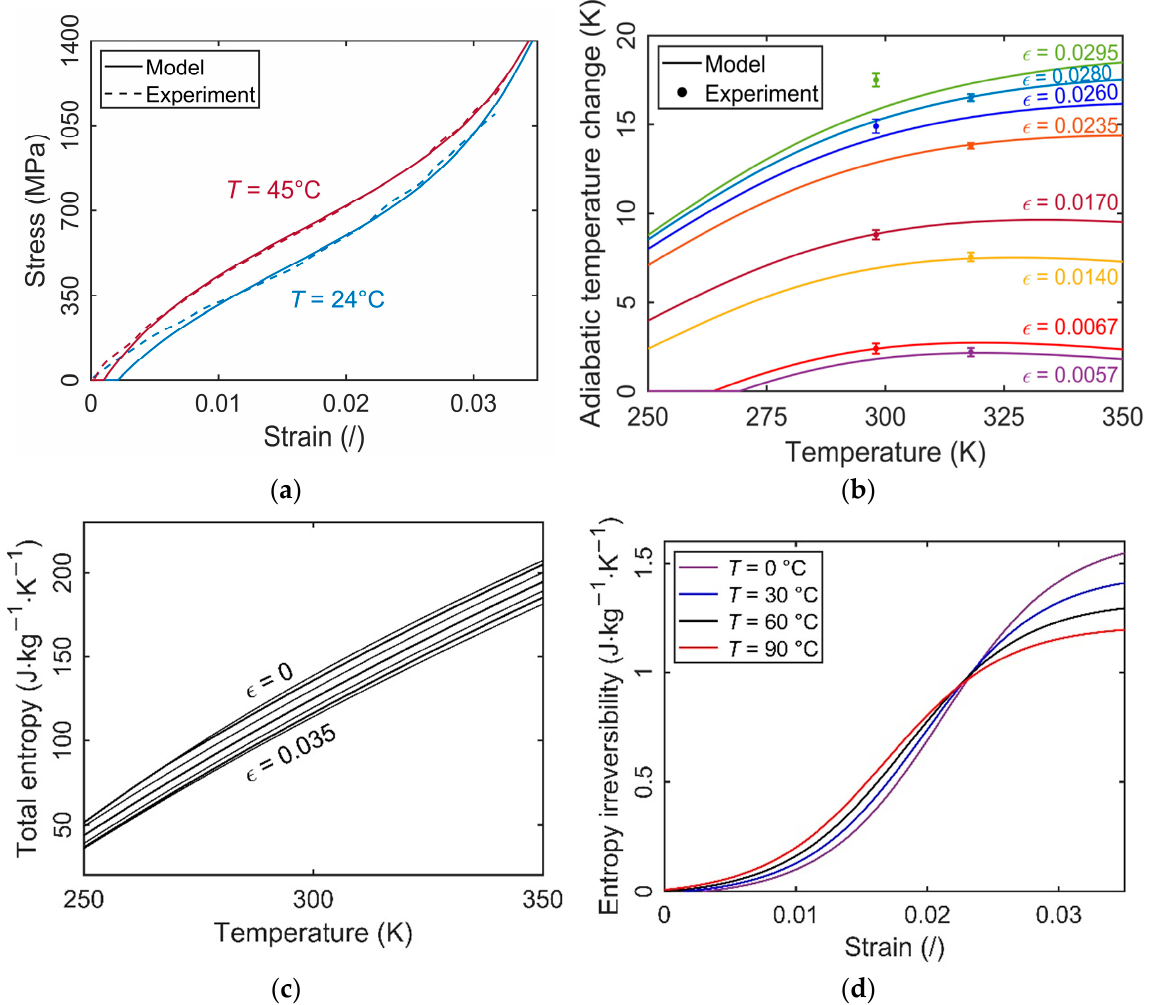
Figure 3. Comparison of experimentally determined and modeled superelastic behavior at different temperatures ( a ); comparison of experimentally determined and modeled positive adiabatic temperature changes during loading ( b ); entropy-temperature diagram ( c ); Modelled entropy irreversibilities as a function of strain at different temperatures ( d ).